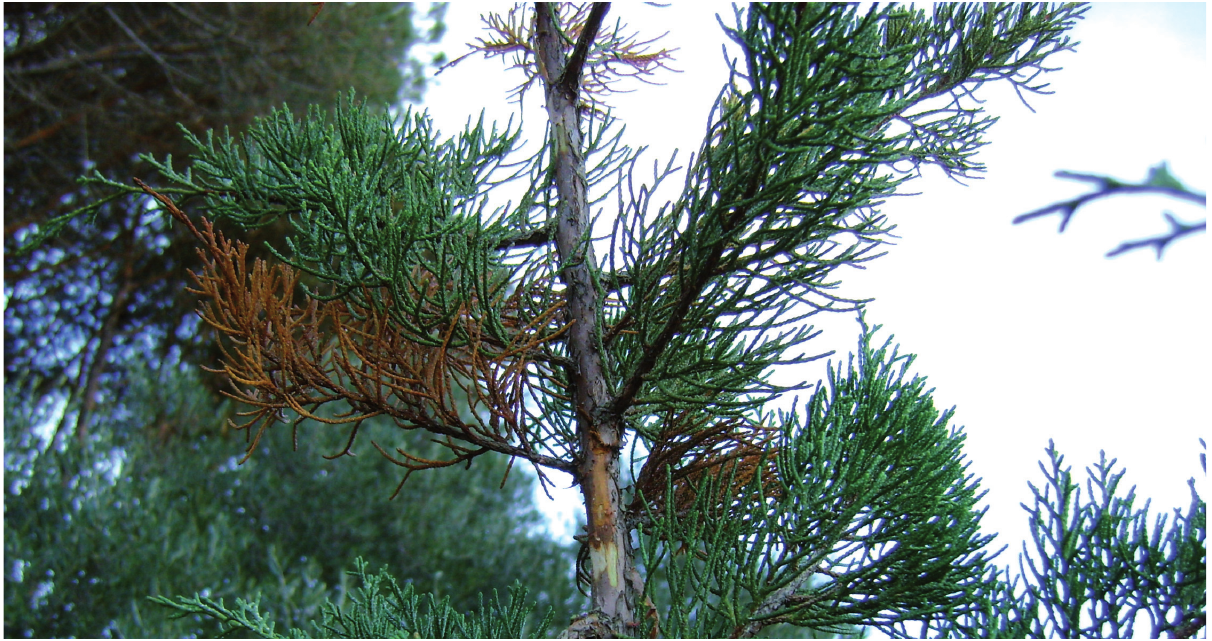
Figure 2. Brown discoloration of wood and inner bark tissues on a symptomatic branch of Phoenicean juniper infected by Diplodia africana